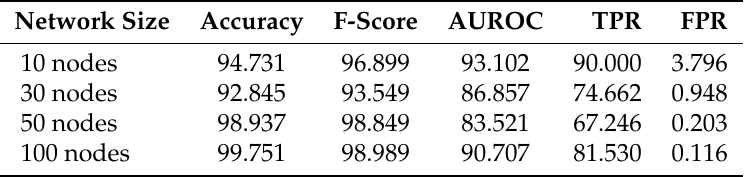
Table 6. Cluster-based detection performance without route cache from the malicious